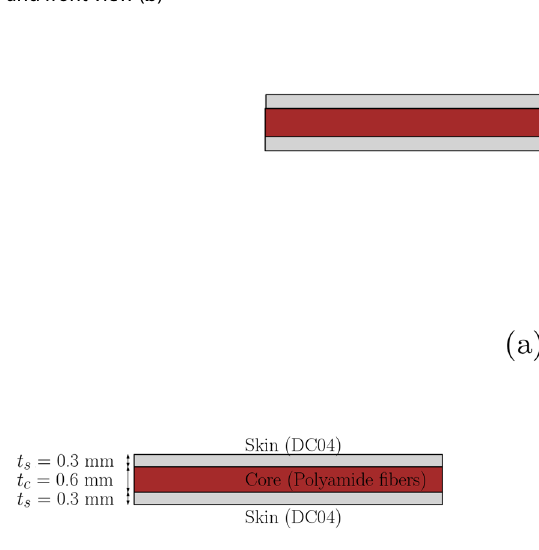
Fig. 3 T-peel test used for vali- dating numerical models. Side view ( a ) and front view ( b )